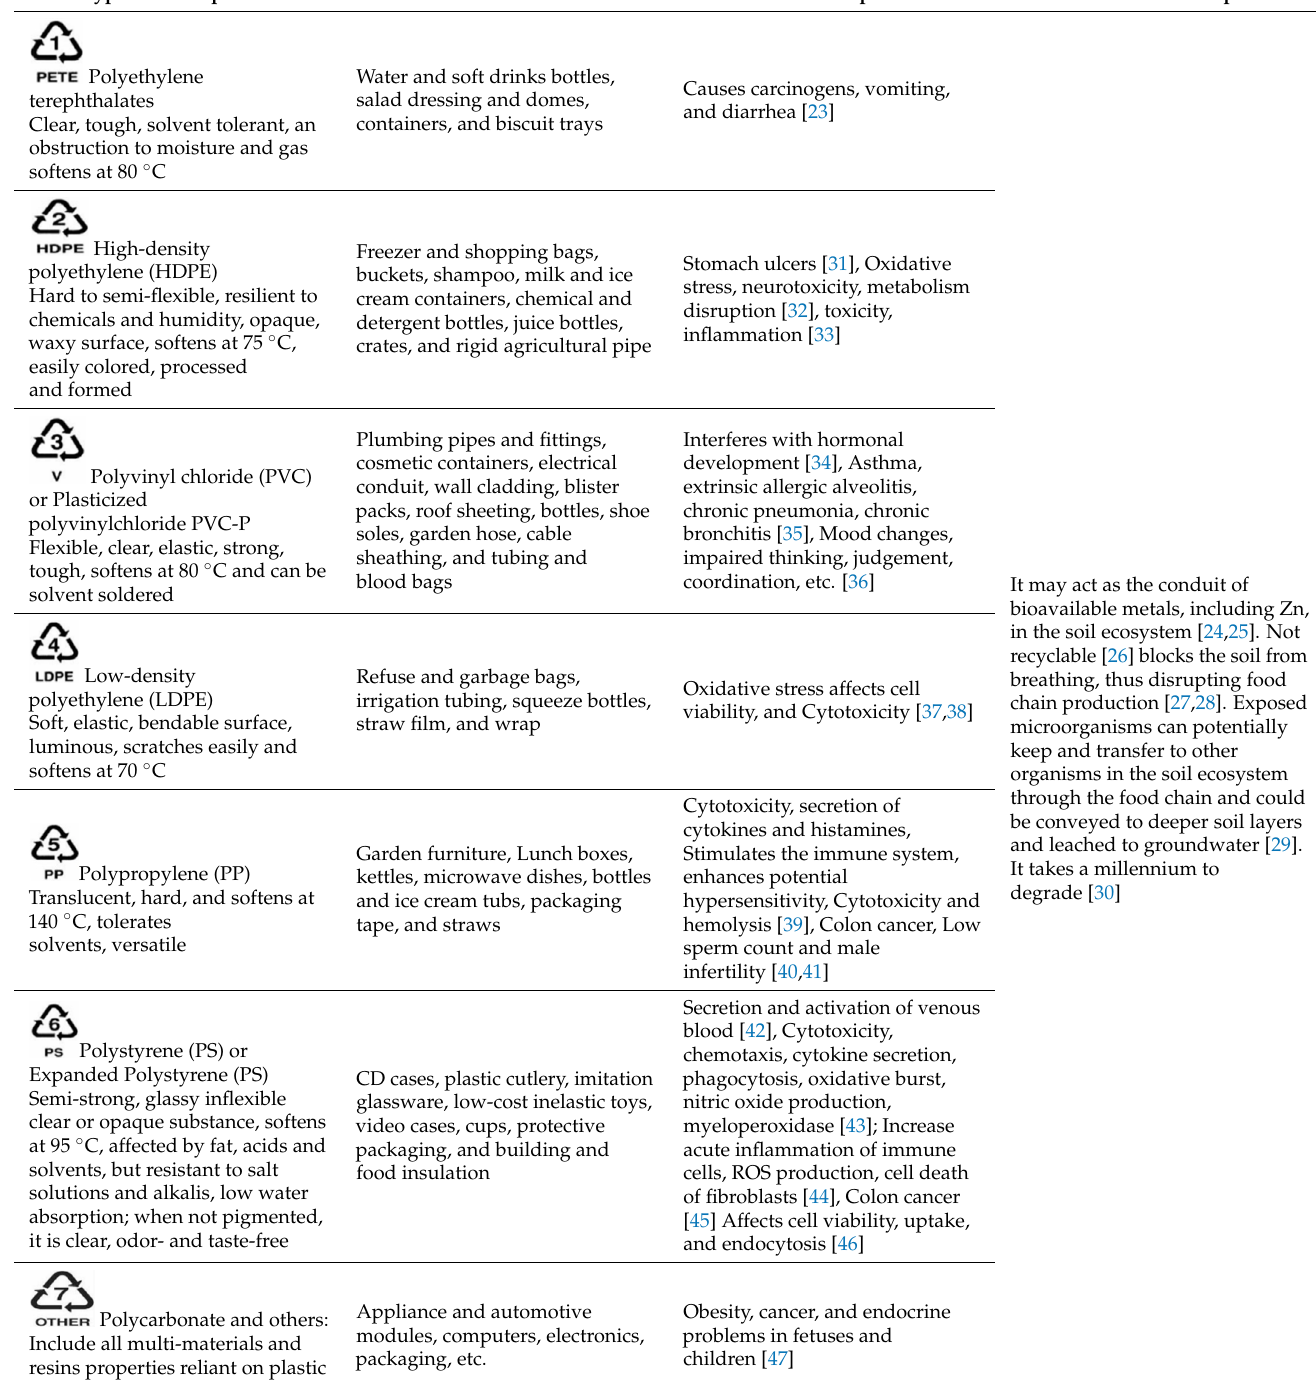
Table 1. Types, properties, and common uses of plastic and the impact of its pollutants.